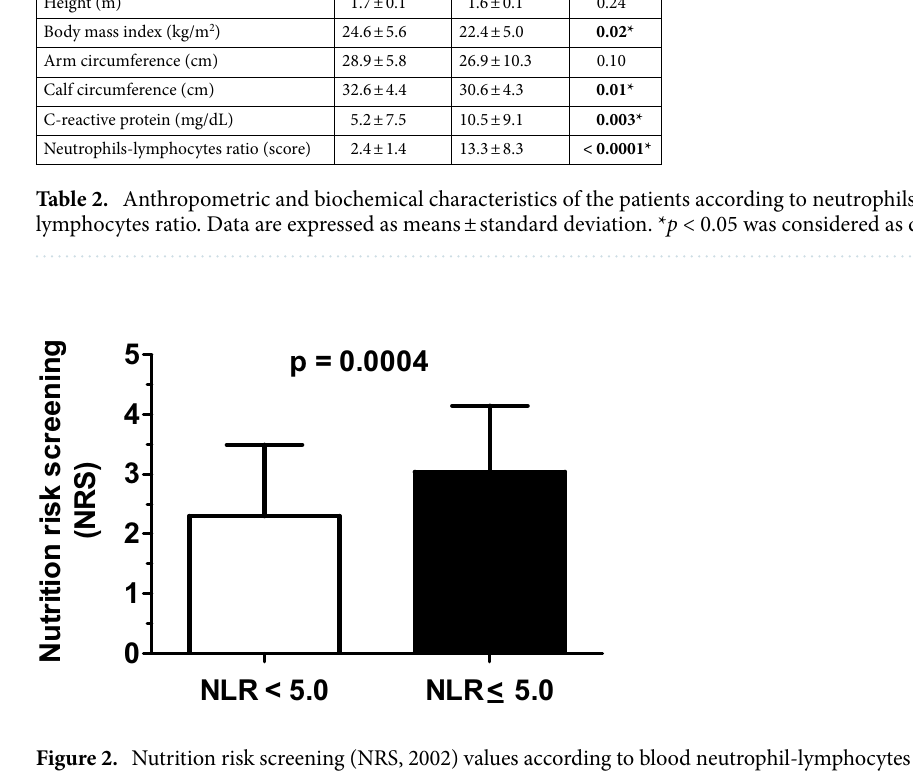
Figure 2. Nutrition risk screening (NRS, 2002) values according to blood neutrophil-lymphocytes ratio (NLR).